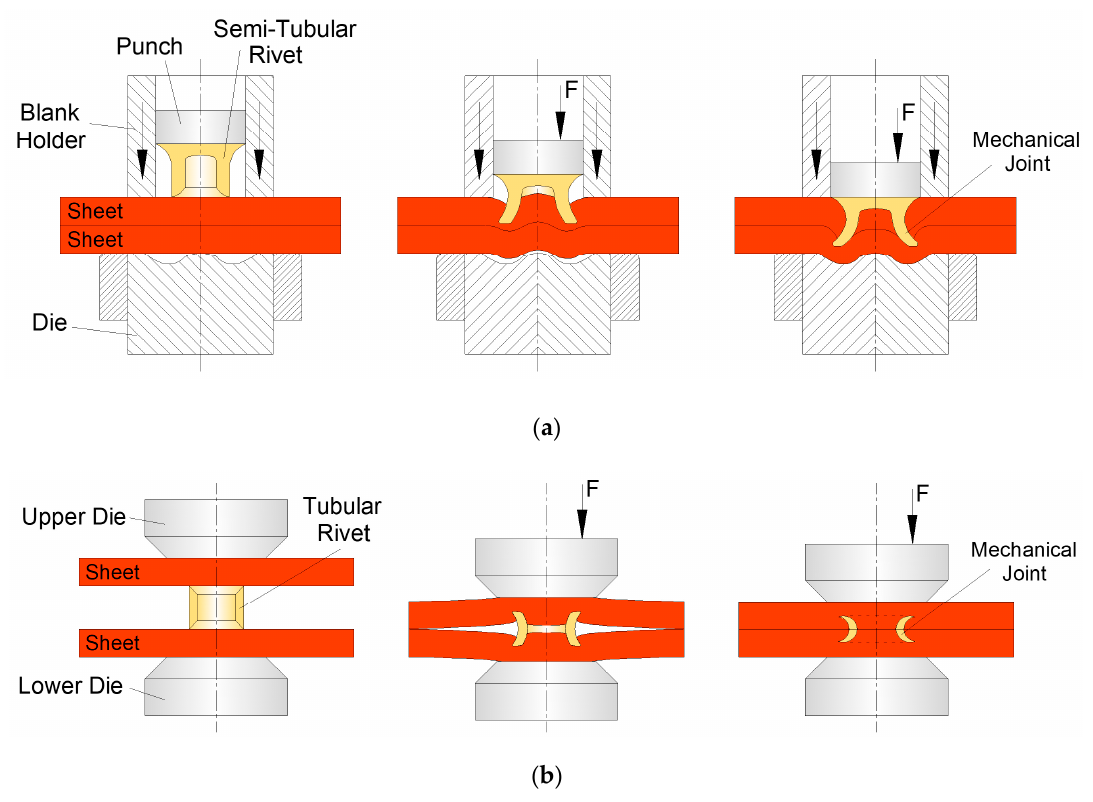
Figure 1. Schematic representation of the process sequence for joining sheets by means of ( a ) self- pierce riveting and ( b ) double-sided self-pierce riveting.